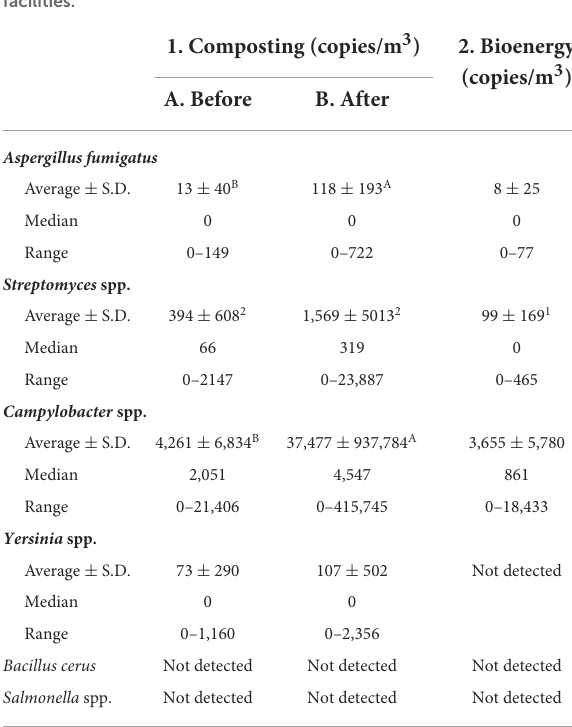
TABLE 2 The averages ± S.D., medians, and ranges of DNA copies of A. fumigatus , Streptomyces spp., Campylobacter spp., Yersinia spp., B. cereus group, and Salmonella spp. in nasal swab samples collected in composting facilities before and after the work shift, and in bioenergy